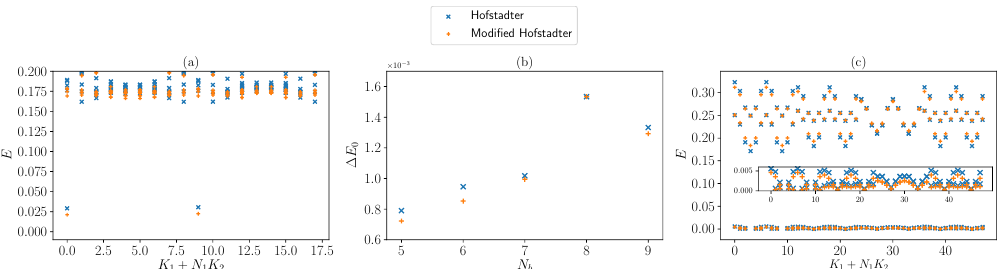
Figure 5: (a) The many-body spectrum at half filling for a 4-band ( φ = 1 / 4) Hofs- tadter model and its modified version with the constant Berry curvature for a lattice × N /φ = 9 × 8 sites. (b) The two-fold ground state degeneracy splitting ∆ E of N 1 2 × 2 /φ lattice. When the lattice half filling for different systems of N bosons in a N b b = 8), the modified model has the same ground state energies is perfectly square ( N b as the original model hence the same ground state splitting. (c) The two-body spec- × N = 12 × 4 magnetic unit cells. The inset shows the lowest trum for a system of N 1 2 non-zero two-body energies per total momentum sector for both